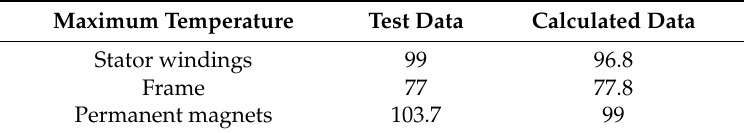
Table 3. The maximum temperature comparison of calculated results and test data (°C).